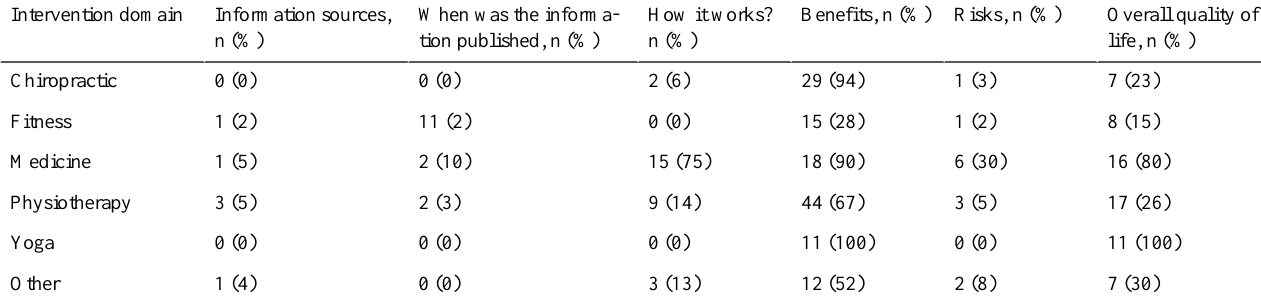
Table 3. Results of modified Brief DISCERN